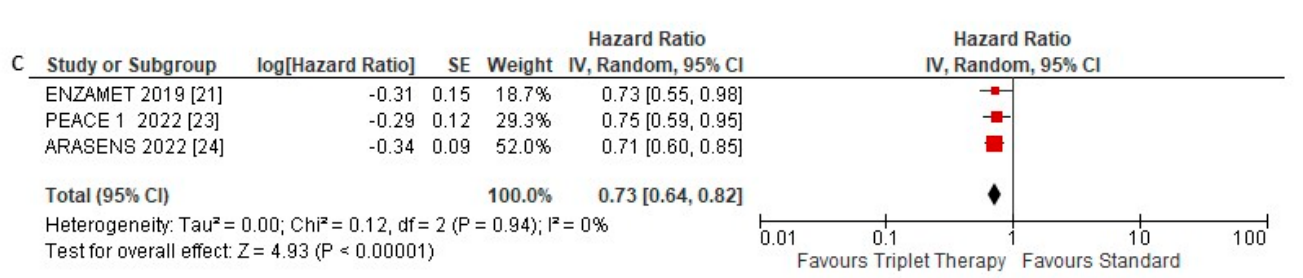
Figure 5. Forest plot of adverse events obtained using fixed